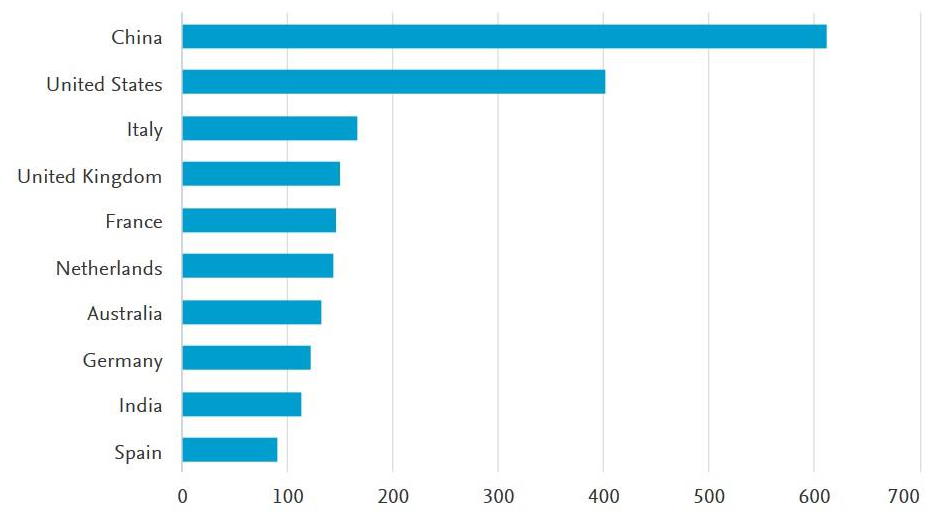
Figure 3. Distribution of publications on business models and food supply chain in different countries.